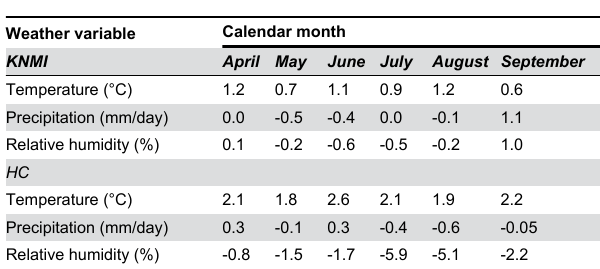
Table 1. Monthly mean changes in temperature (° C), precipitation (mm/day) and relative humidity (%) as projected for the Netherlands by the KNMI model and the HC model for 2031-2050 relative to 1975-1994.